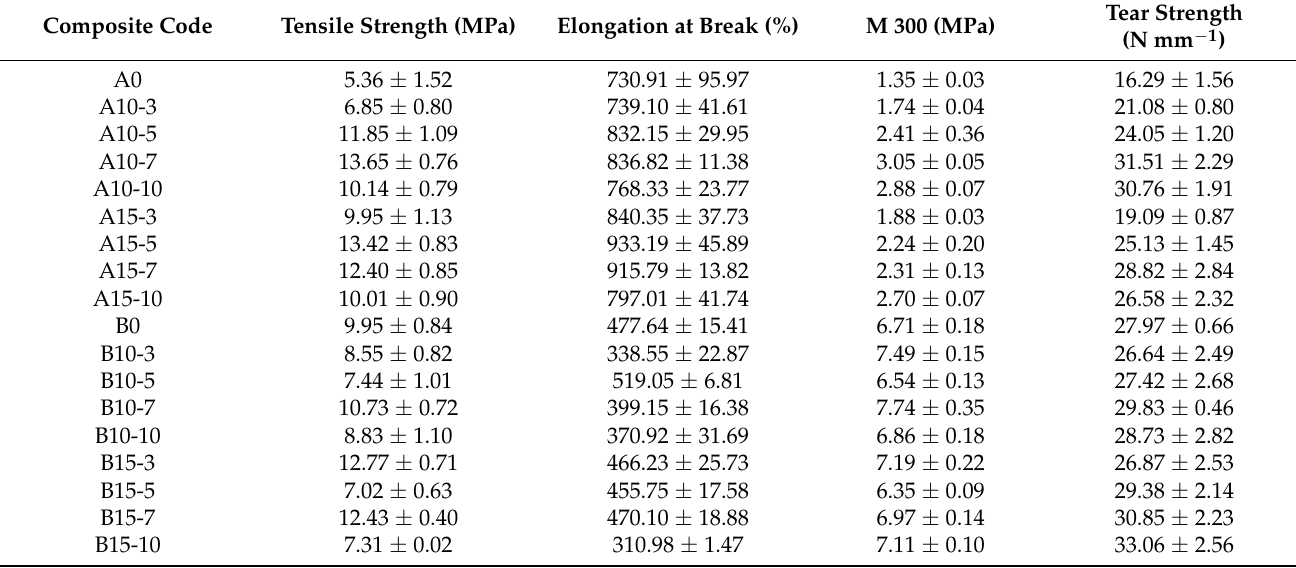
Table 3. Mechanical properties of the rubber nanocomposites. The data presented are the average values and their standard